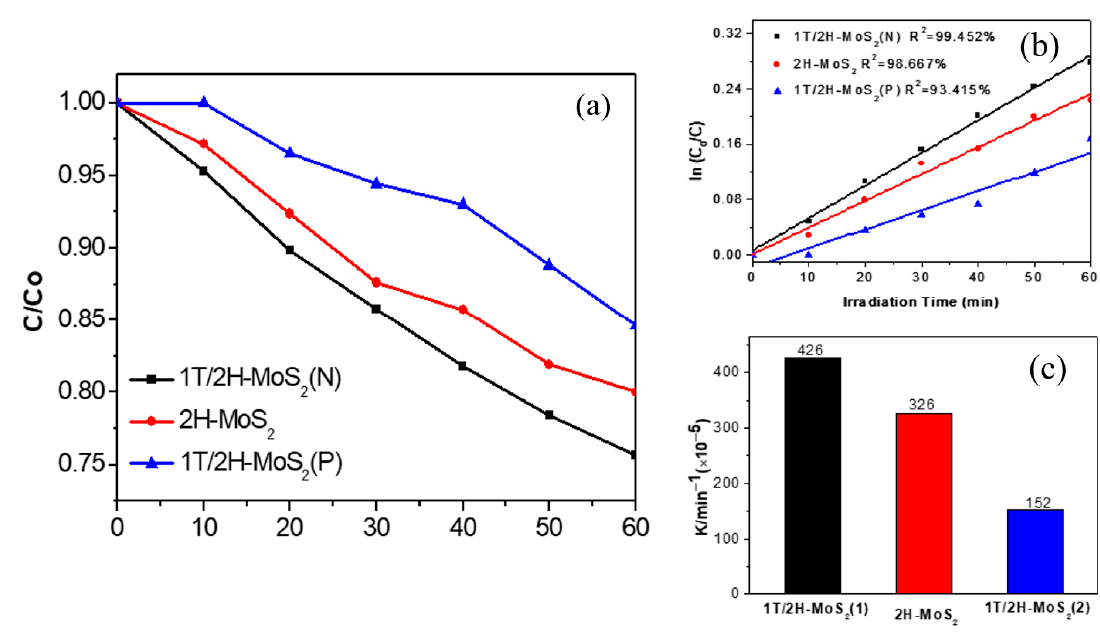
Figure 7. ( a ) Photodegradation of TC-HCl on 1T/2H-MoS 2 (N), 2H-MoS 2 , and 1T/2H-MoS 2 (P); ( b ) First-order kinetic fitting curve of TC-HCl degradation on 1T/2H-MoS 2 (N), 2H-MoS 2 , and ( b ) First-order kinetic fitting curve of TC-HCl degradation on 1T / 2H-MoS 2 (N), 2H-MoS 2 , 1T/2H-MoS 2 ; ( c ) Histogram of the degradation reaction constant k . and 1T / 2H-MoS 2 ; ( c ) Histogram of the degradation reaction constant k